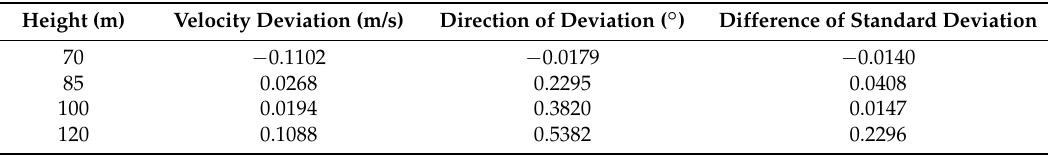
Figure 13. Horizontal wind speed deviation against SNR. Table 4. Error of CWL using CR-CFAR at different heights.